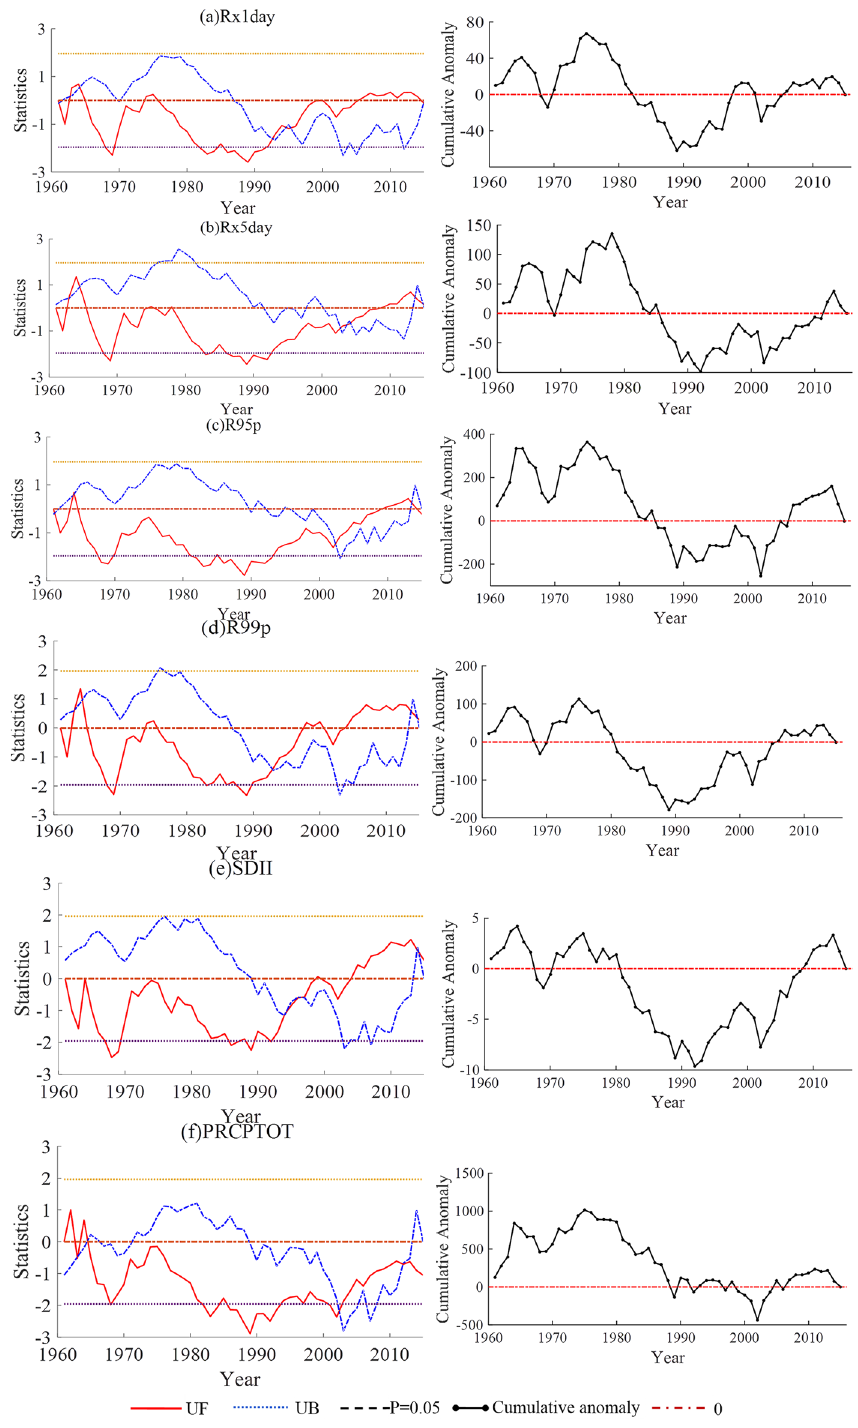
Figure 6. Temporal variations of indices related to the amount of precipitation in Shandong from 1961 to